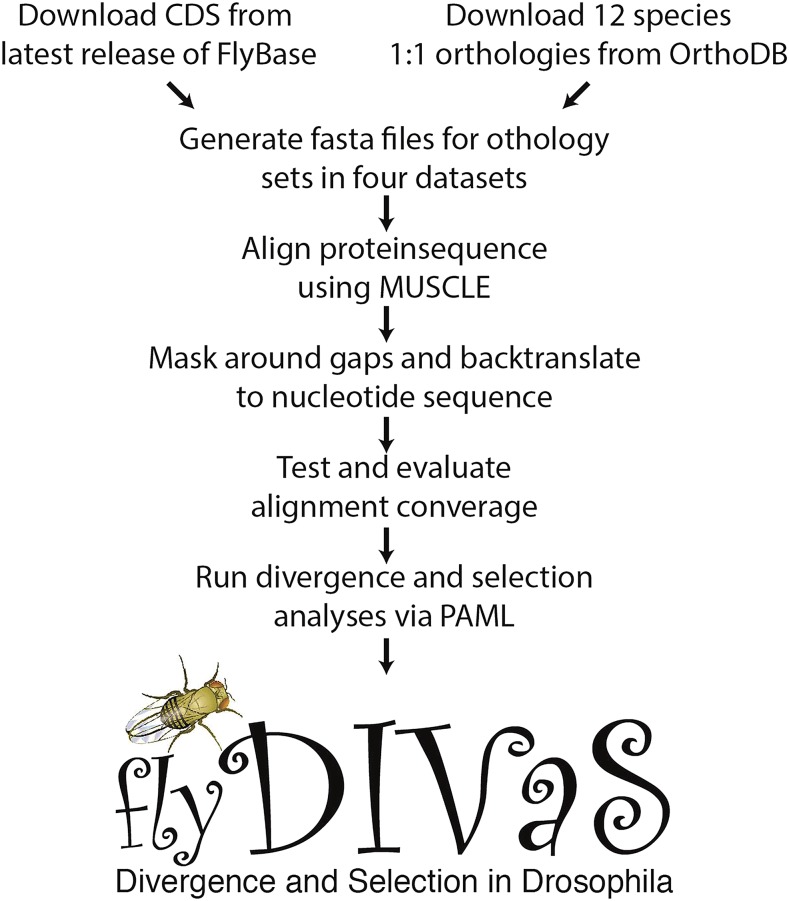
Data flow and analyses in flyDIVaS. This database of Drosophila divergence and selection is based on 1:1 orthology calls of curated CDS fasta files from species of the 12 Drosophila genome project (Clark et al. 2007) referenced against D. melanogaster.